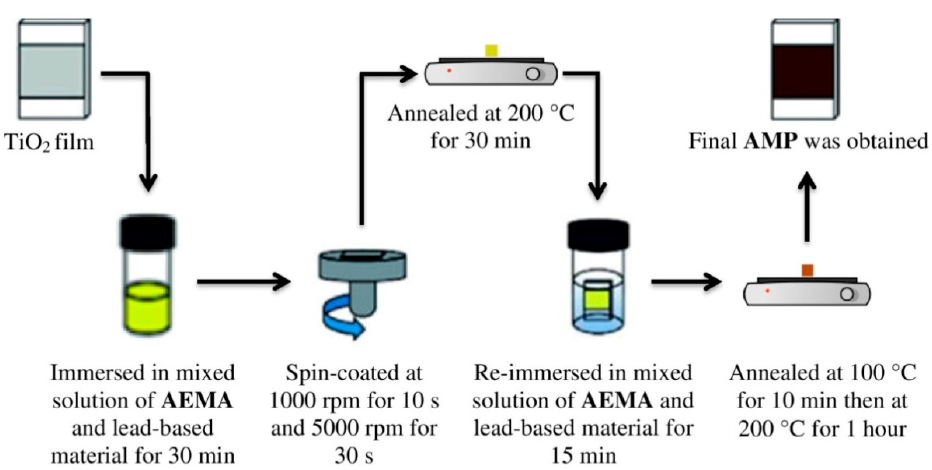
Figure 3. Synthesis of AMP from 2 ‐ Aminoethyl methacrylate hydrochloride (AEMA) and lead ‐ based materials (I or N), respectively.